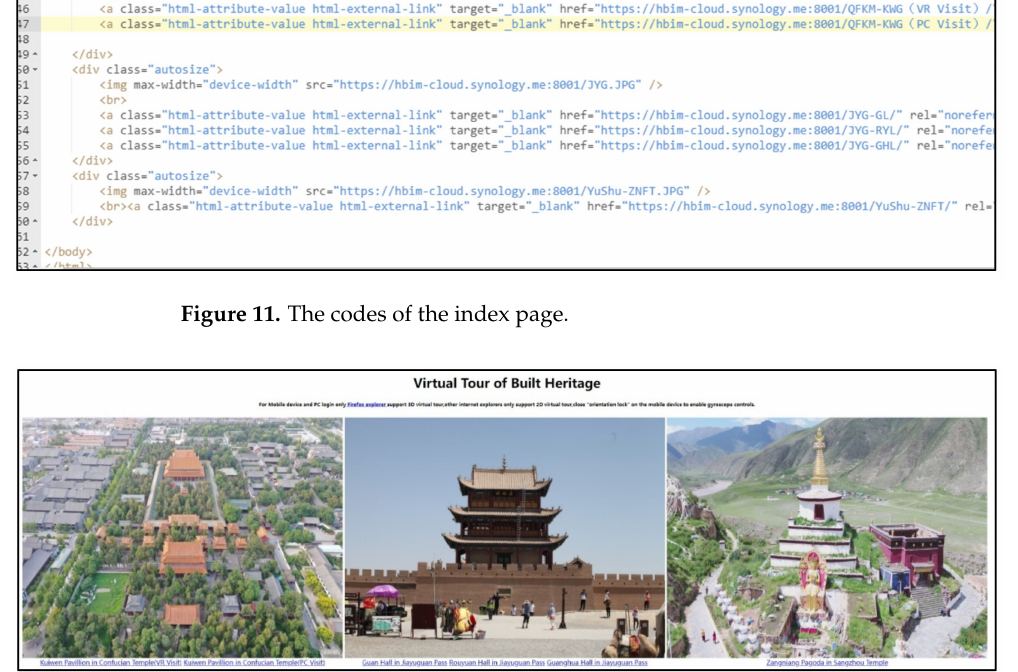
Figure 12. The index page of the Virtual Tour on a PC through Internet Explorer (https://hbim-cloud. synology.me:8001/, accessed on 1 December